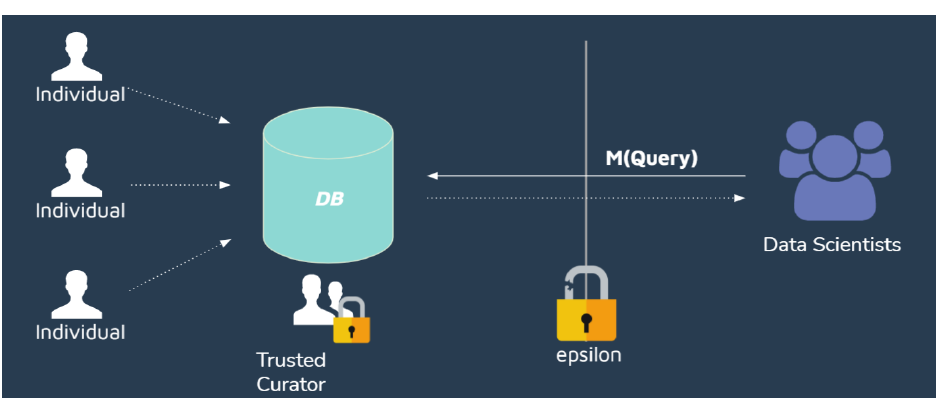
Figure 3. Centralized